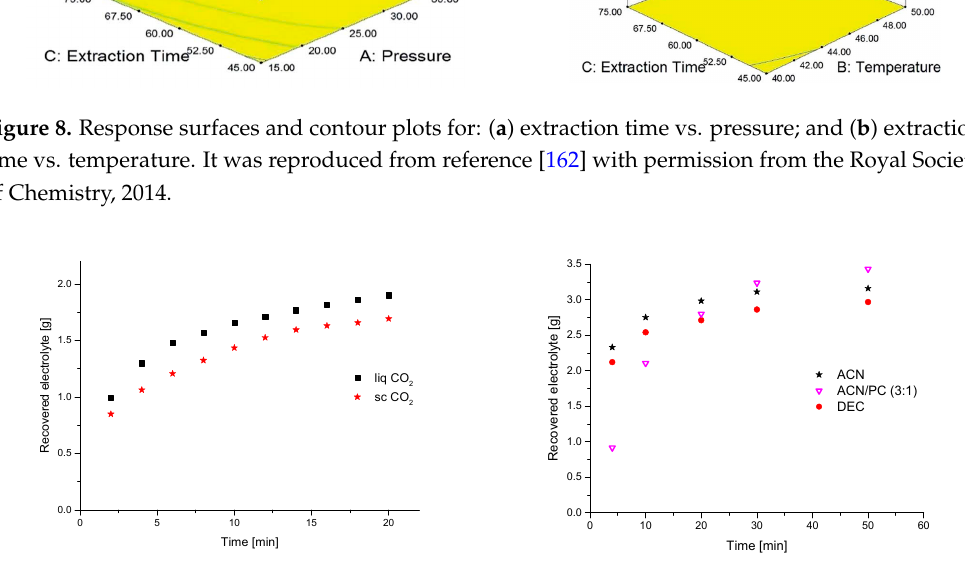
Figure 9. ( Left ) Time dependency of the amount of recovered electrolyte from commercial 18,650 cells after formation extracted with supercritical (300 bar, 40 °C; red stars) and liquid (60 bar, 25 °C; black squares) CO 2 ; and ( Right ) time dependency of the amount of recovered electrolyte from commercial 18,650 cells after formation extracted with liquid CO 2 and 0.5 mL/min additional solvents (black stars: acetonitrile (can); magenta triangles: ACN/propylene carbonate (PC) (3:1); red circles: diethyl carbonate (DEC)). It was reproduced from reference [163] with permission from the Royal Society of Chemistry, 2015.